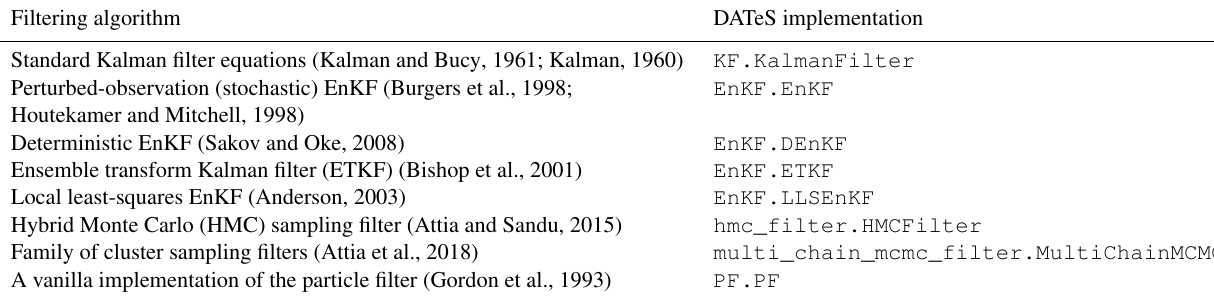
Table 3. DA filtering routines provided by the initial version of DATeS v1.0. Filtering algorithm DATeS